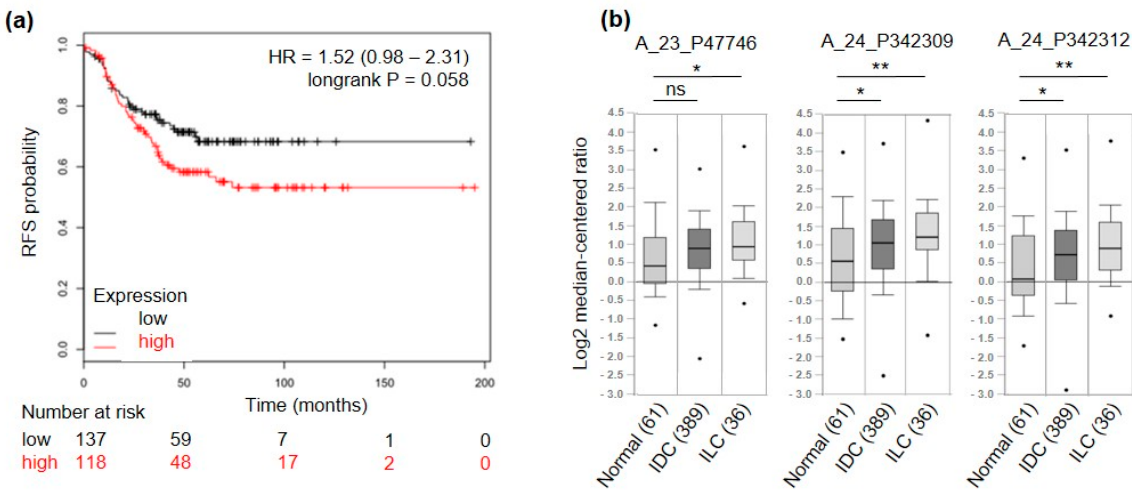
Figure 3. TENM4 relevance in breast cancer patients. ( a ) RFS of TNBC patients, stratified by high (red) or low (black) expression of TENM4 mRNA. ( b ) Oncomine TENM4 mRNA expression data reported as log2 median-centered ratio using box-and-whiskers plots (dots: maximum and minimum values; whiskers: 90/10 percentiles; box: 75/25 percentiles; line: median of all samples). Expression data from normal breast tissue (61 samples) were compared with those from invasive ductal carcinoma (IDC, 389 samples) and invasive lobular carcinoma (ILC, 36 samples). The analysis was performed for three different Agilent ID probes. * p < 0.05; ** p < 0.01; ns: non-significant.